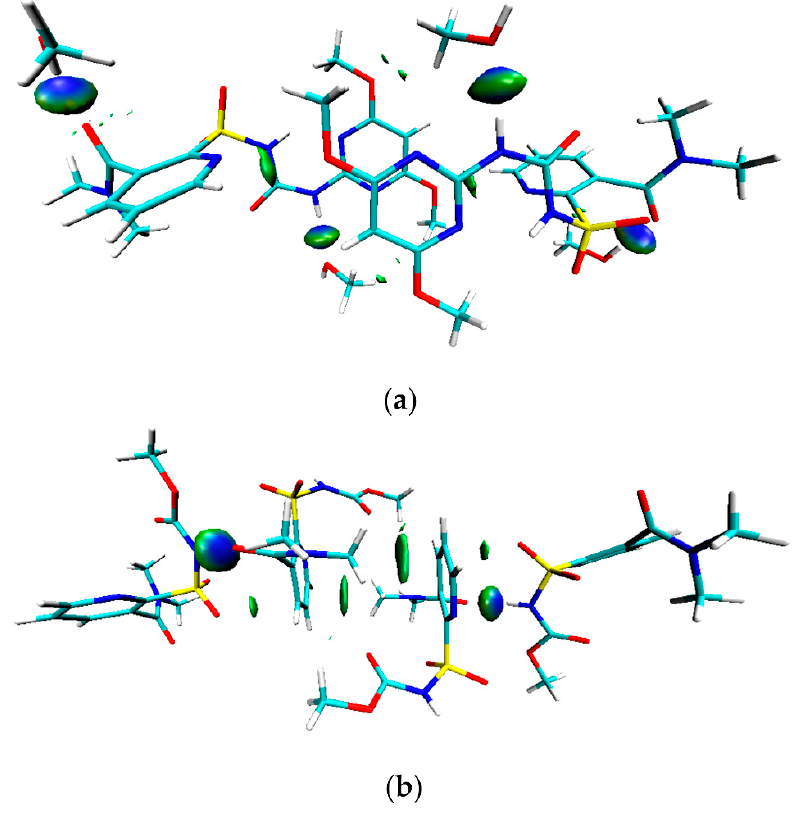
Figure 6. VMD figures on the basis of independent gradient model (IGM) analysis of different molecules in ( a ) NS-MeOH and ( b ) PCM.